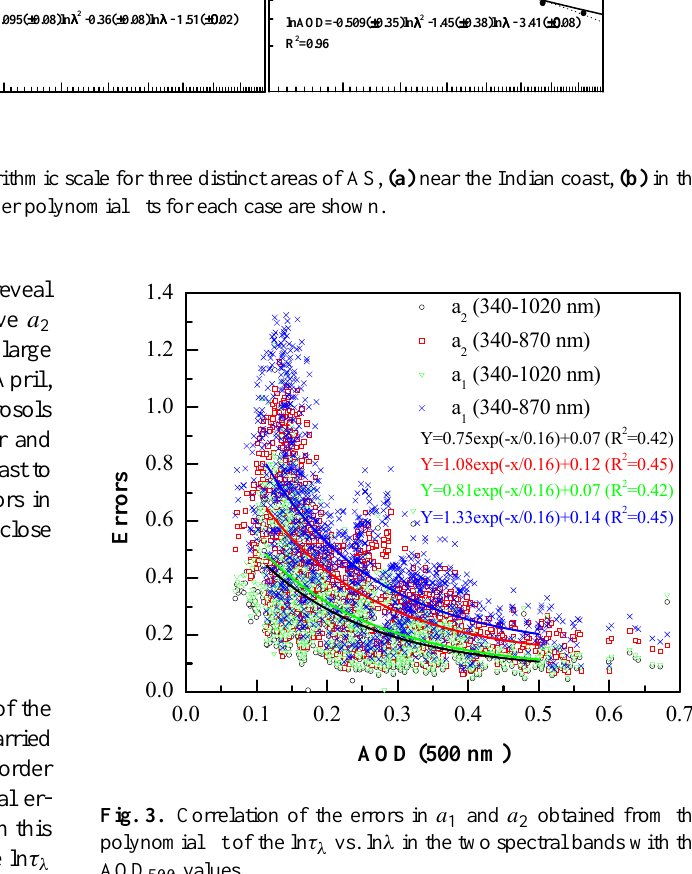
Fig. 2. Spectral variation of the AOD vs. wavelength in logarithmic scale for three distinct areas of AS, (a) near the Indian coast, (b) in the northern AS and, (c) in the far AS. The linear and the 2nd order polynomial fits for each case are shown.